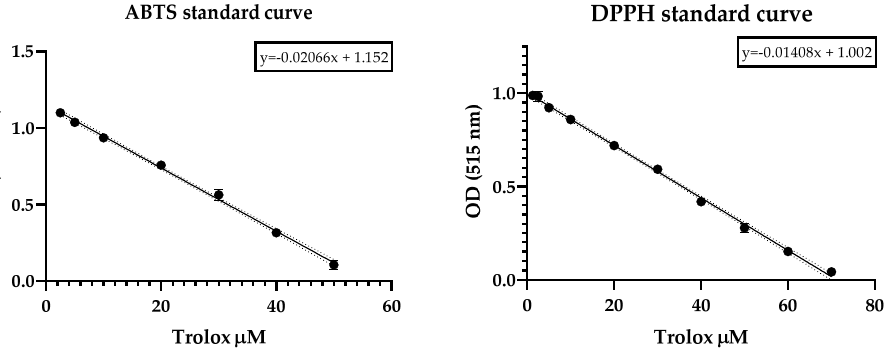
Figure 1. Scavenging effect of Trolox on ABTS and DPPH radicals revealed as a rapid decrease in optical density as a function of the dose.